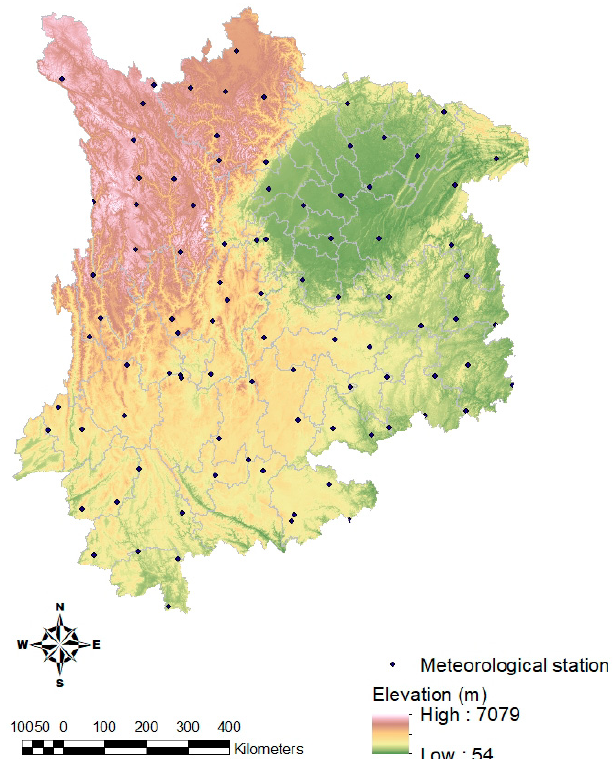
Figure 1. The location of meteorological stations and terrain in the study area.